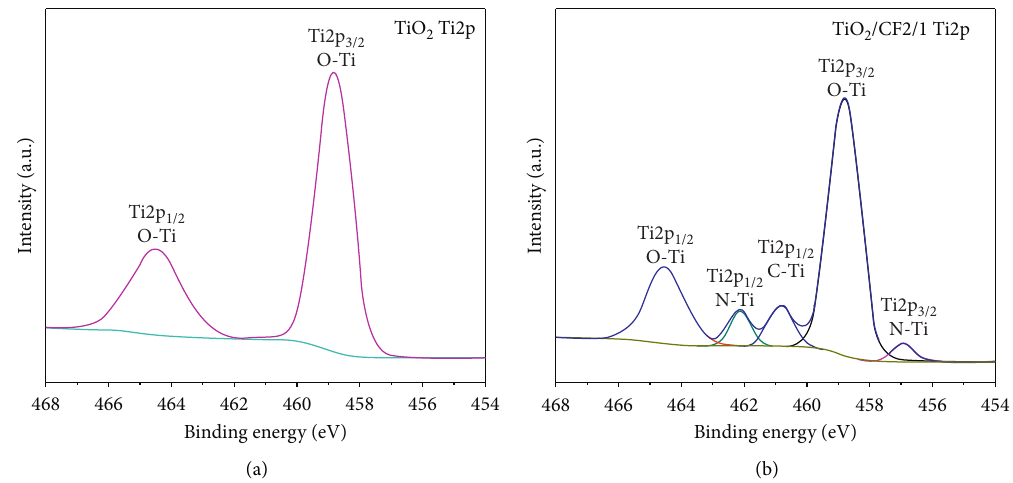
Figure 9: Ti 2p high-resolution XPS spectra of (a) TiO